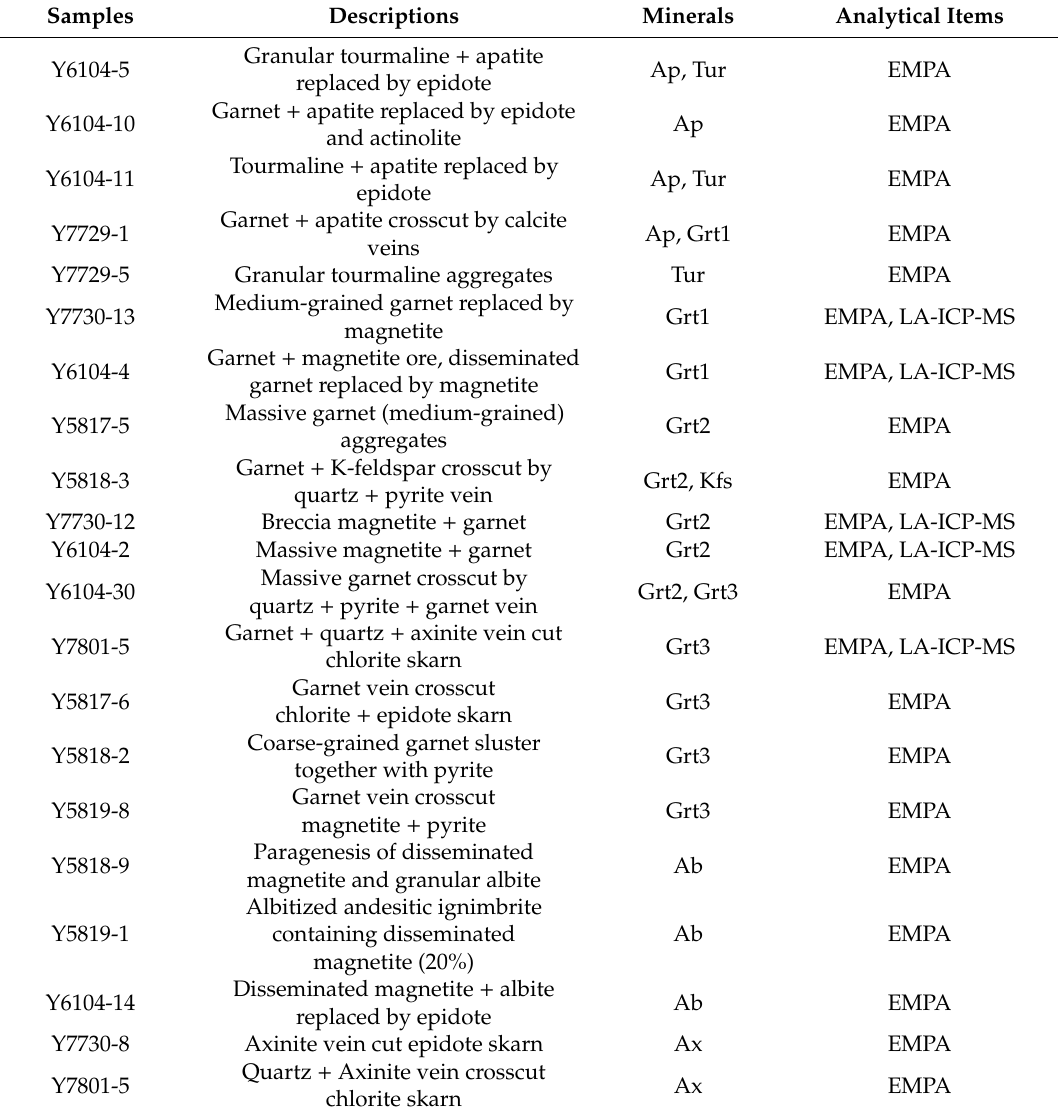
Table 1. The mineral samples and their characteristics from the Yamansu